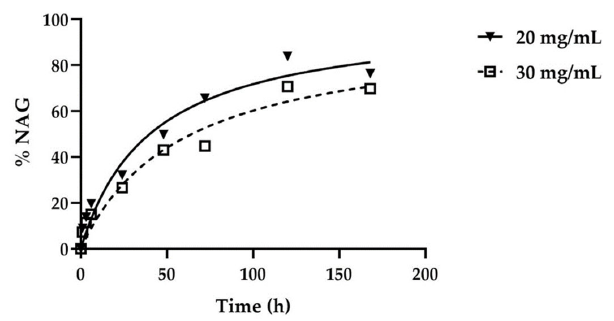
Table 3. Degradation parameters of analyzed hydrogels containing 20 or 30 mg/mL hyaluronic